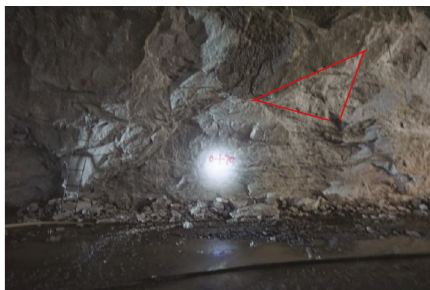
Figure 25: Fault slip-type rockburst on the upstream side of the pilot tunnel in K0+70 m of the main transformer chamber.